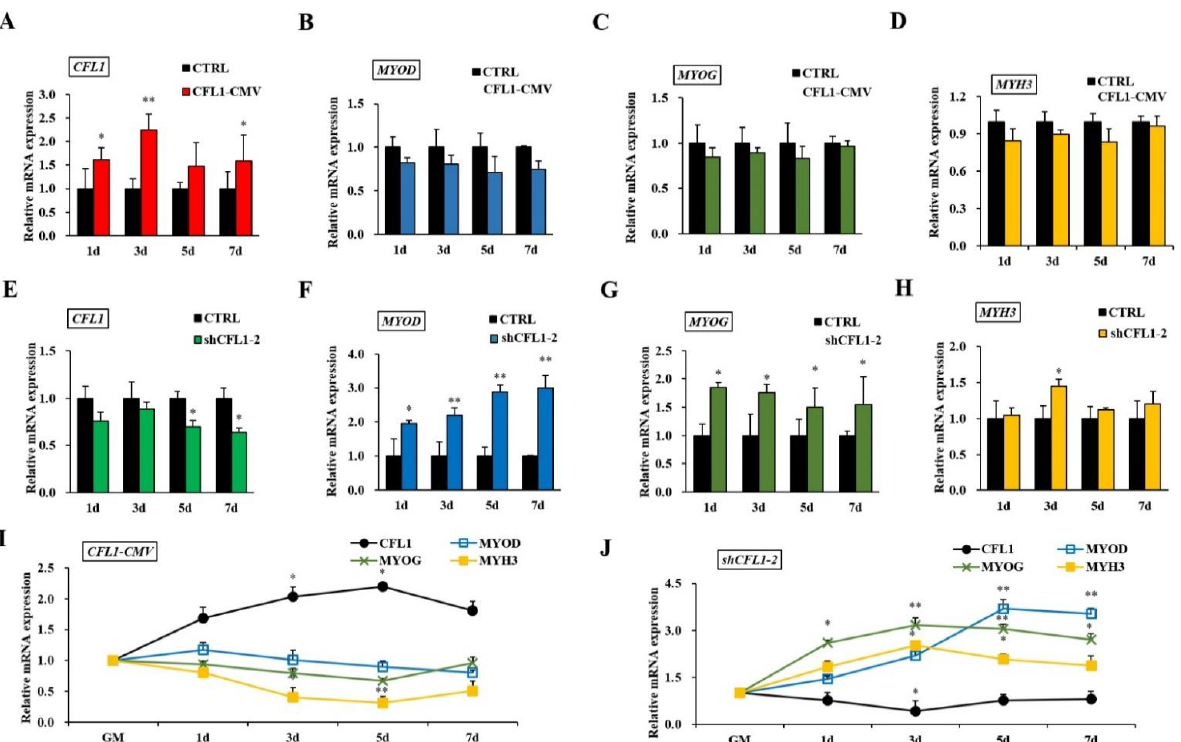
Figure 5. Effects of the CFL1 gene on the differentiation of bovine primary myoblasts. Expression of CFL1 , MYOD , MYOG and MYH3 were detected by qRT-PCR after being transfected with CFL1-CMV into bovine primary myoblasts and induced for 1, 3, 5, 7 days by 2% horse serum ( A – D ). Expression of CFL1 , MYOD , MYOG and MYH3 was detected by qRT-PCR after being transfected with shCFL1-2 into bovine primary myoblasts and induced for 1, 3, 5, 7 days by 2% horse serum ( E – H ). Expression trends of CFL1 gene and myogenesis factors were detected by qRT-PCR after being transfected with CFL1-CMV or shCFL1-2 into bovine primary myoblasts and induced for 1, 3, 5, 7 days by 2% horse serum, the expression levels of four genes in GM were considered as 1 ( I , J ). The mRNA expression level was normalized to GAPDH . Data are means ± SE of n = 3 independent experiments, each performed in triplicate. *, p < 0.05 and **, p < 0.01, two-tailed t test. CTRL, Control. GM, growth medium.